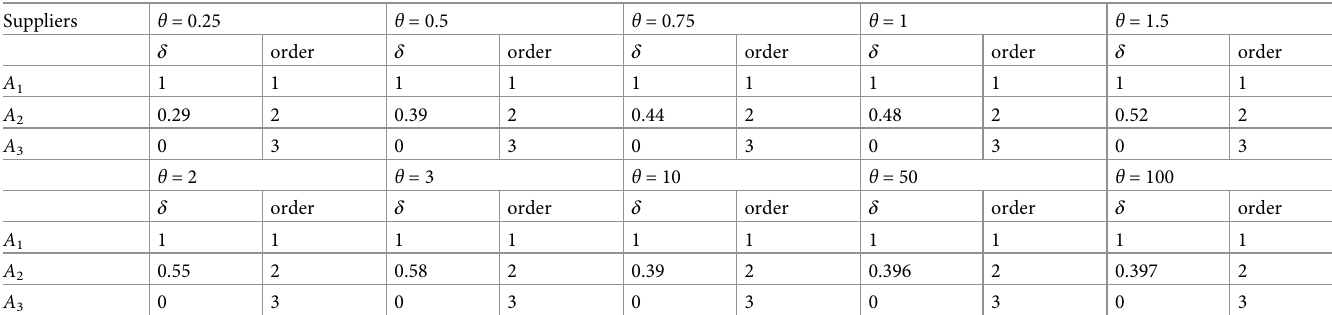
Table 11. Ranking results for different θ